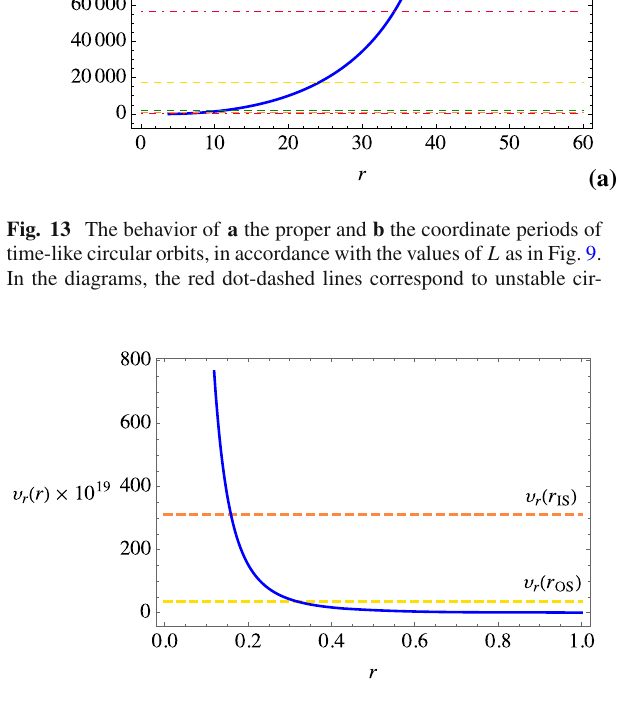
Fig. 14 The radial profile of the epicyclic frequency together with its values at the two radii of marginally stable orbits ( r IS and r OS ), in accordance with the effective potential in Fig.